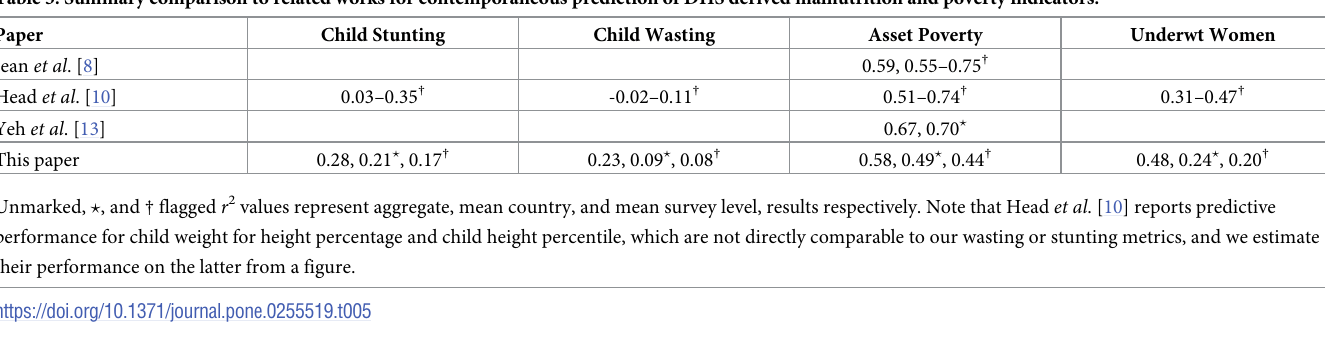
Table 5. Summary comparison to related works for contemporaneous prediction of DHS derived malnutrition and poverty indicators. Paper